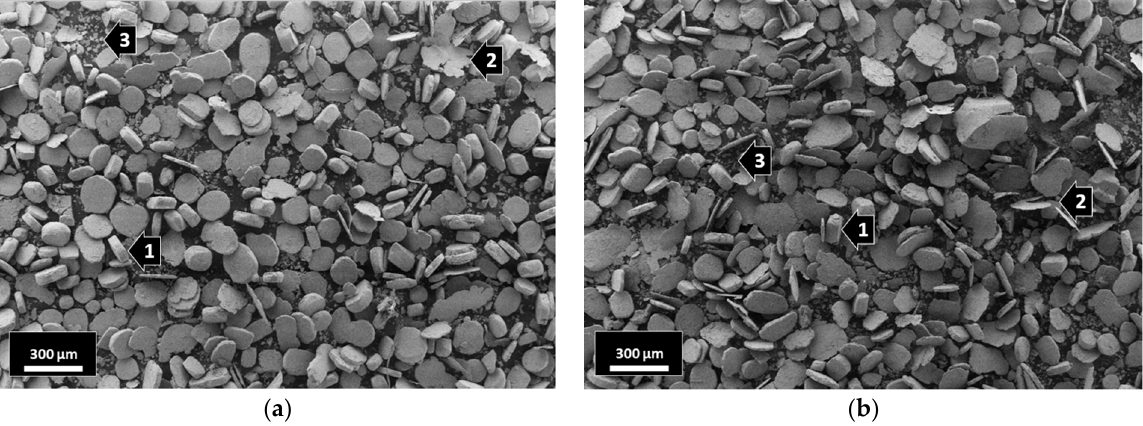
Figure 2. SEM images of the milled composites: ( a ) 316L/0.33 wt% Al 2 O 3 ; ( b ) 316L/1 wt% Al 2 O 3 .